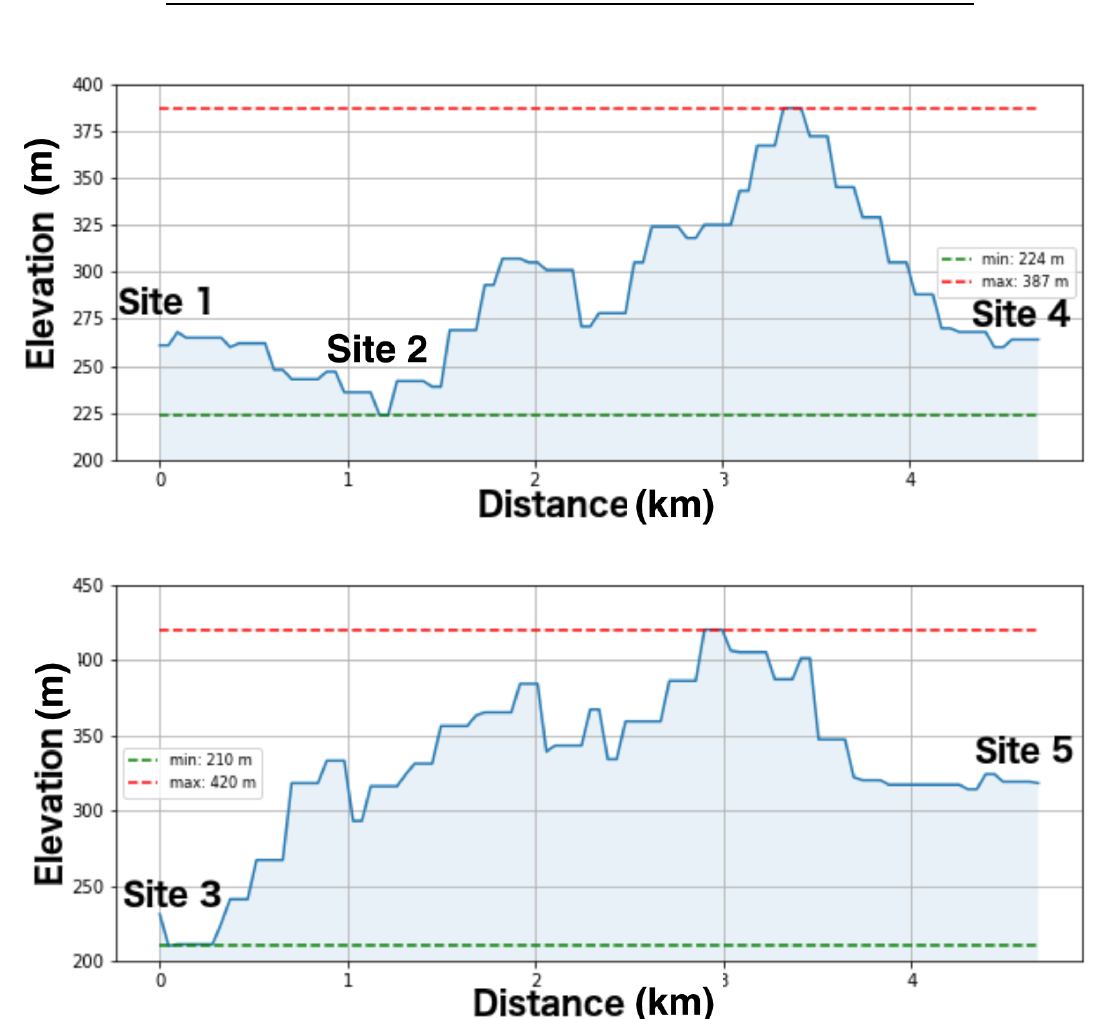
Figure 2. ( Above ): horizontal topographical profile across Rödeser Berg between Site 1 and Site 4, crossing Site 2. ( Below ): topographical profile along the ridge of Rödeser Berg, between Site 3 and Site